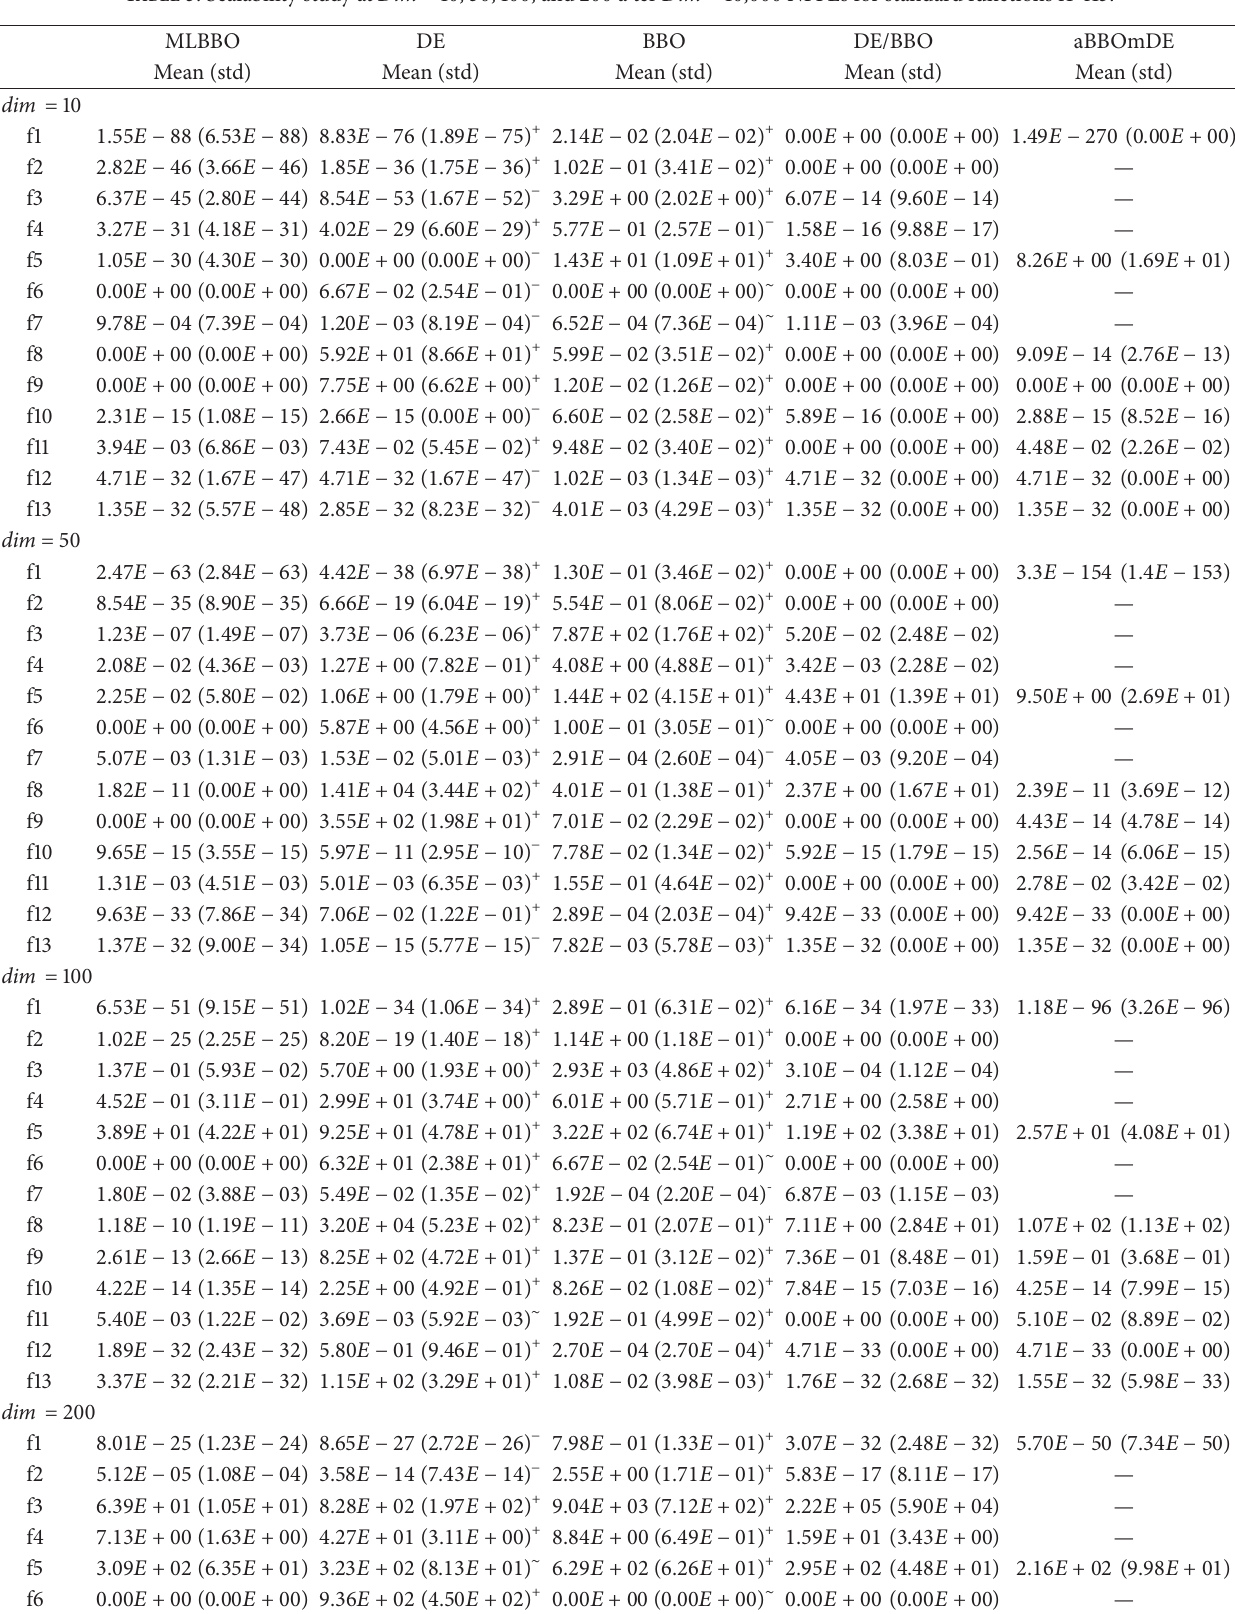
Table 5: Scalability study at Dim = 10, 50, 100, and 200 a ter Dim ∗ 10,000 NFFEs for standard functions